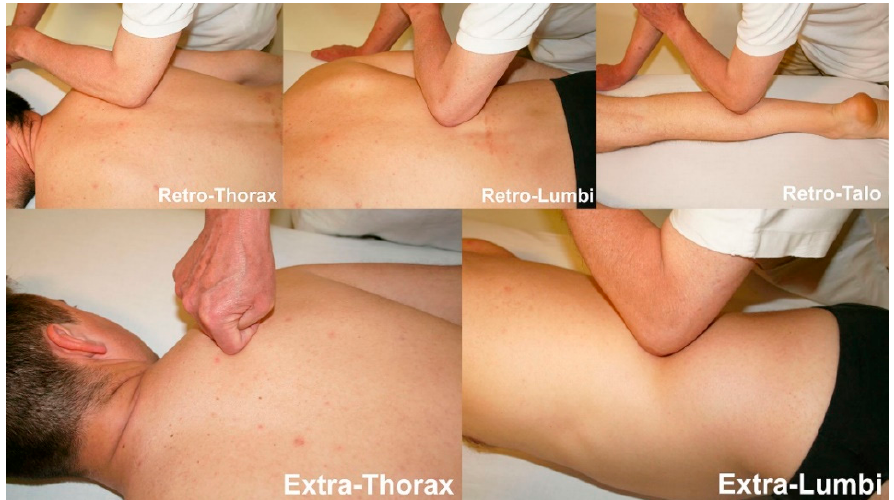
Figure 4. Examples of the location of some of the Centers of Coordination (CC), namely, retro-lumbi, retro-talus, retro-thorax, extra-thorax and extra-lumbi and the treatment modalities applied in these points.